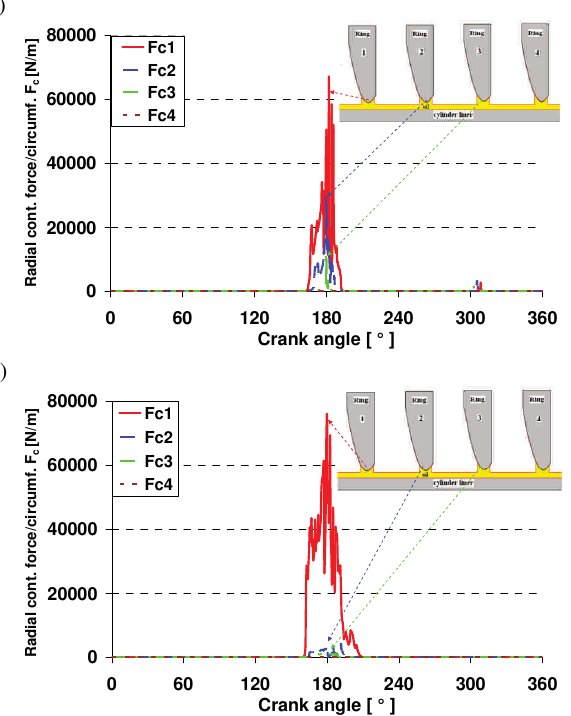
Fig. 7. Variation in radial component of contact force F c_i for each piston ring (i – ring number) versus crank angle. Piston ring pack configuration: a) 4xSC, b) GT+3xSC Analysing the presented results it can be concluded that hydrodynamic forces (Fig. 6) are generated by relatively low pressure acting on a large surface in contrast to high local contact pressure concentrated on a very small area of elastic contact (Fig. 7). Due to that the elastic contact seems to be responsible for the wear process. Near the top dead centre (at high oil temperature) the additional tangential components of elastic contact forces (friction forces) F for each piston ring should be noticed cx (Fig. 8). But exactly at this piston reverse point the axial Fig. 6. Variation in hydrodynamic force F h_i generated by each piston ring velocity of piston rings decreases to zero, which means the (i – ring number) versus crank angle. Piston ring pack configuration: simultaneous drop of aforementioned forces to zero a) 4xSC, b) GT+3xSC